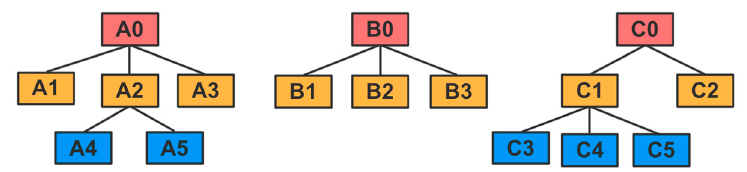
Figure 6. Hierarchical tree structure for attributes A, B and C.